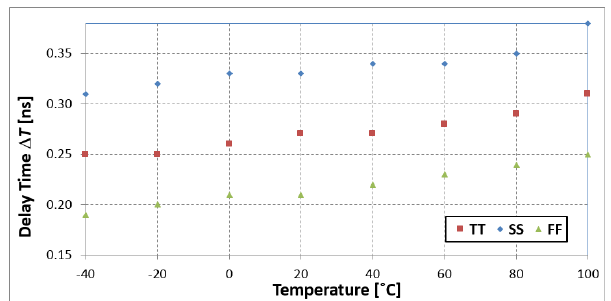
Figure 14. Corner analysis of the proposed solution. An averat delay time per a single ring as a function of transistor model and